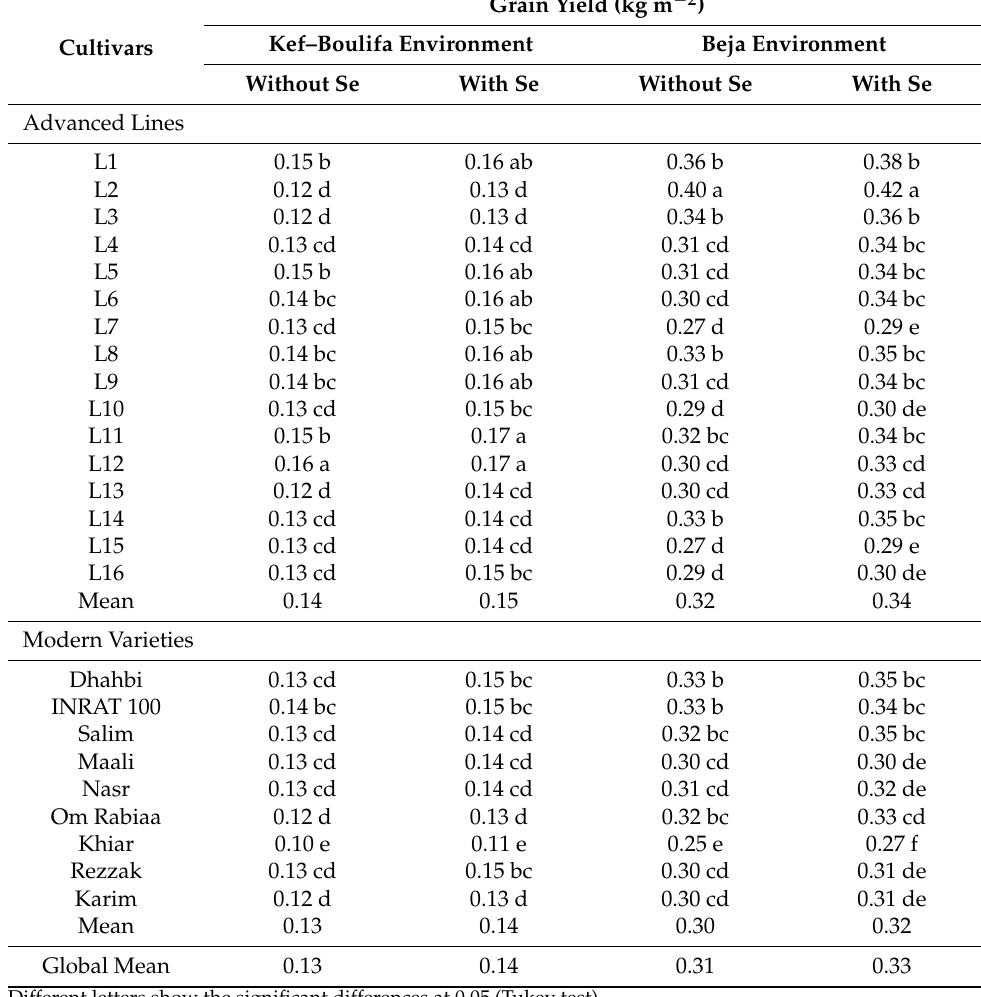
Table 2. Grain yield of 25 durum wheat cultivars across the two environments. Grain Yield (kg m − 2 ) Kef–Boulifa Environment Beja Environment Cultivars